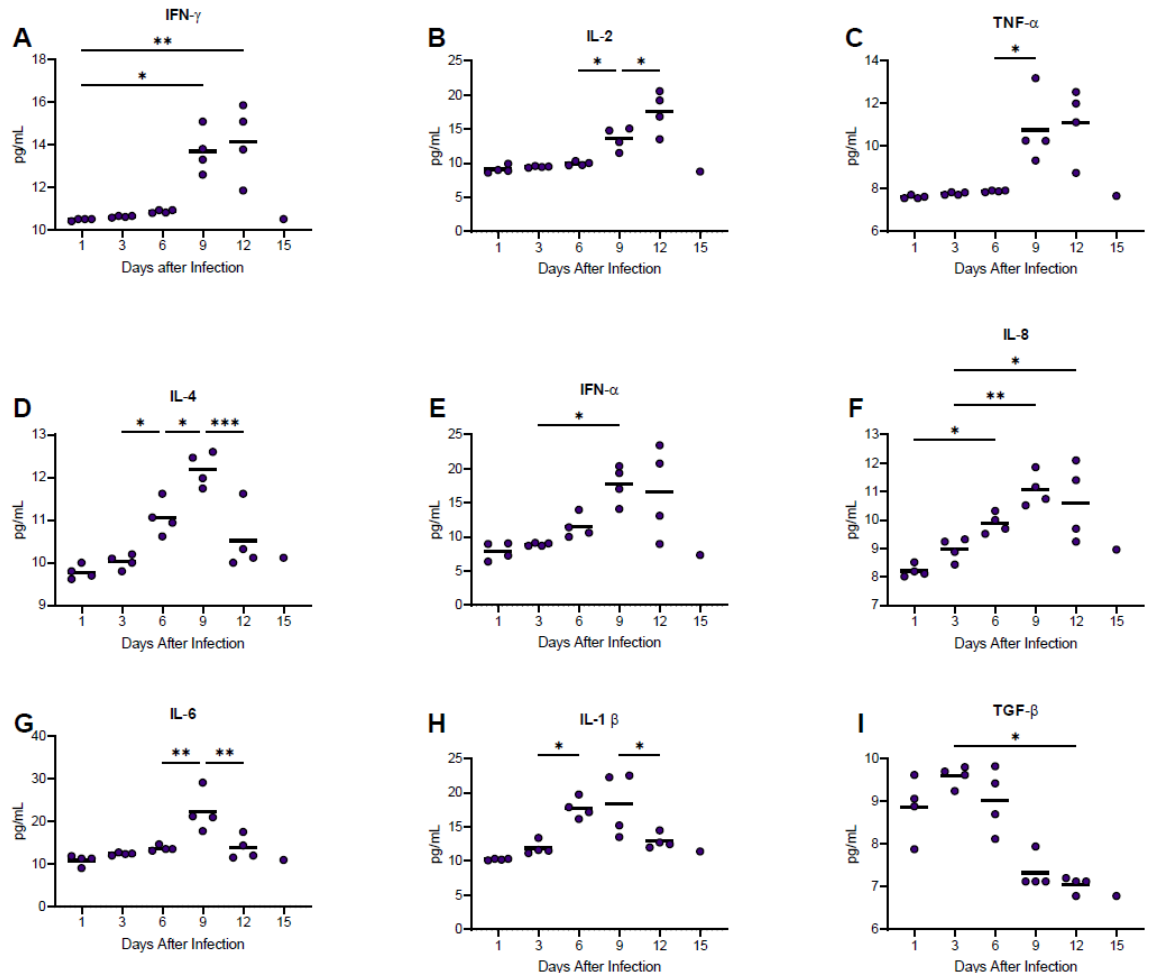
Figure 7. Temporal analysis of host cytokine responses in guinea pigs infected with NML-61/GPA. Twenty-four guinea pigs were inoculated with 100LD 50 of NML-61/GPA. Groups of four animals were euthanized at indicated days post-inoculation and analyzed for IFN-gamma ( A ), IL-2 ( B ), TNF- alpha ( C ), IL-4 ( D ), INF-aIha ( E ), IL-8 ( F ), IL-6 ( G ), IL-1 beta ( H ), and TGF-beta ( I ). Dots represent individual animal values; bar represents group averages. Significant differences where p < 0.05, <0.01, and <0.001 are indicated by *, **, and ***, respectively.